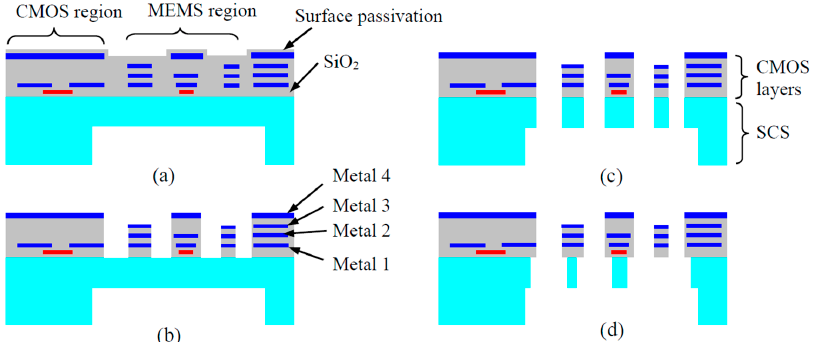
Figure 8. DRIE bulk CMOS-MEMS process flow for 4-metal-layer CMOS [70] . ( a ) Backside silicon DRIE to define MEMS areas; ( b ) Front SiO 2 etching; ( c ) Front-side silicon DRIE; ( d ) Front-side RIE with lateral undercut.